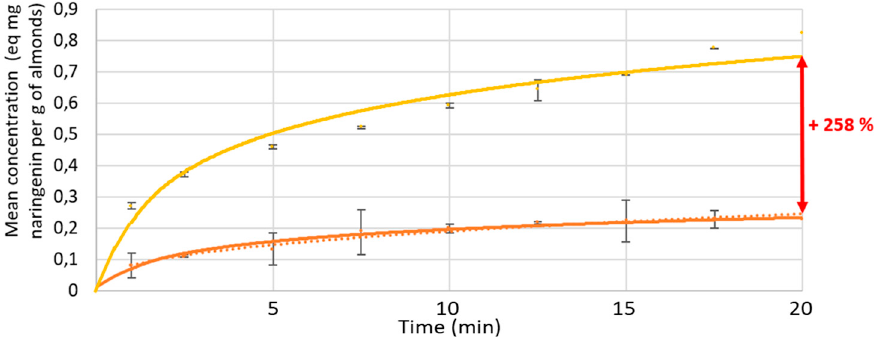
Figure 3. TPC (expressed as eq mg Naringenin/g almonds) kinetics with and without ultrasound. Data are the means ± SD, n = 3. Ultrasound (yellow) versus silent (orange).